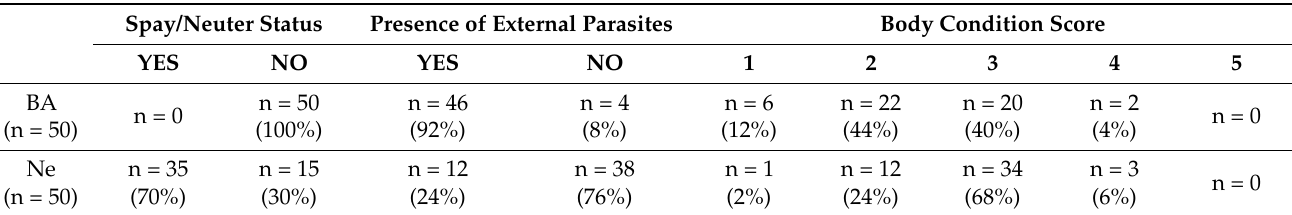
Table 1. Sampled animals’ data by sampling location.